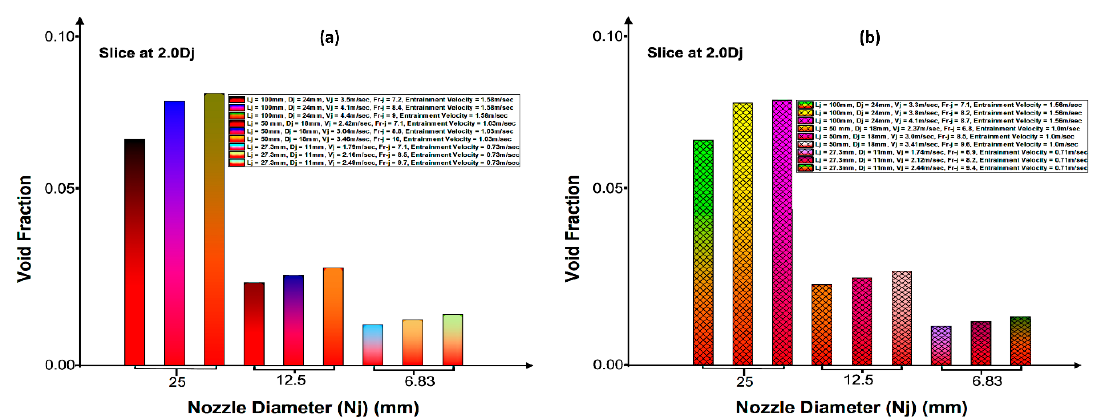
Figure 8. ( a ) VOF Simulated Values; ( b ) Chanson [39] Measured Values for a Peaked Void Fraction at 2.0 D j Depth.